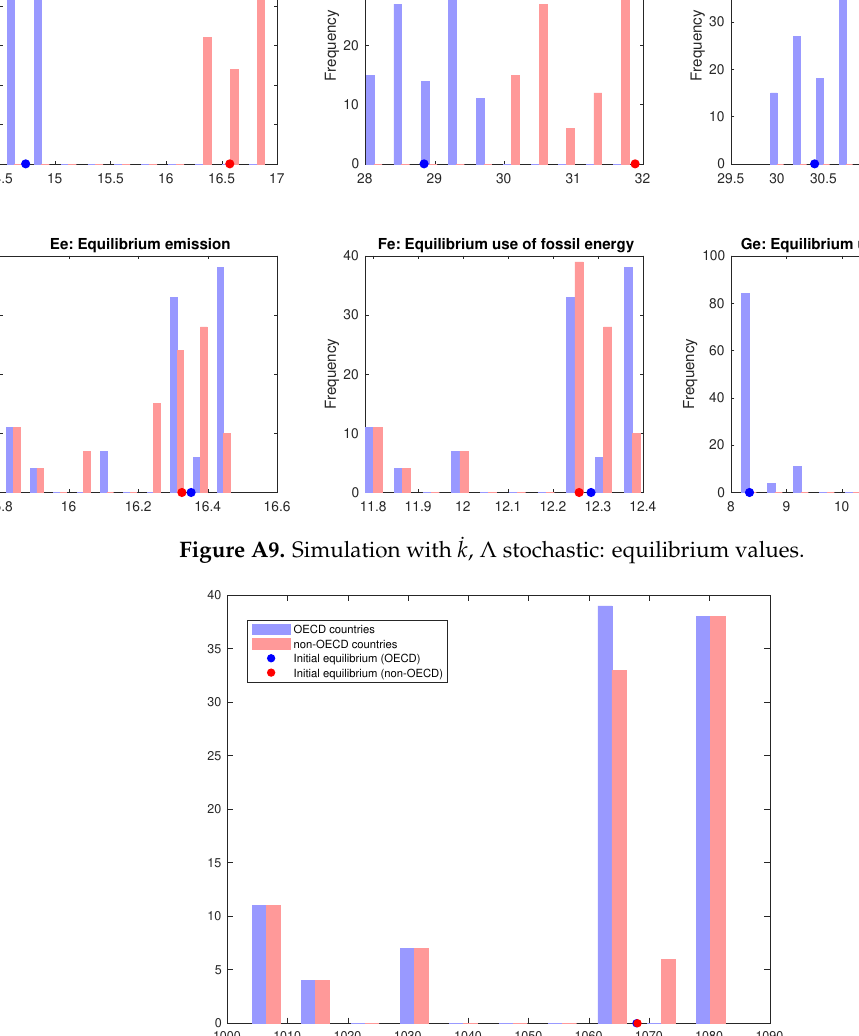
Figure A10. Simulation with ˙ k , Λ stochastic: objective function